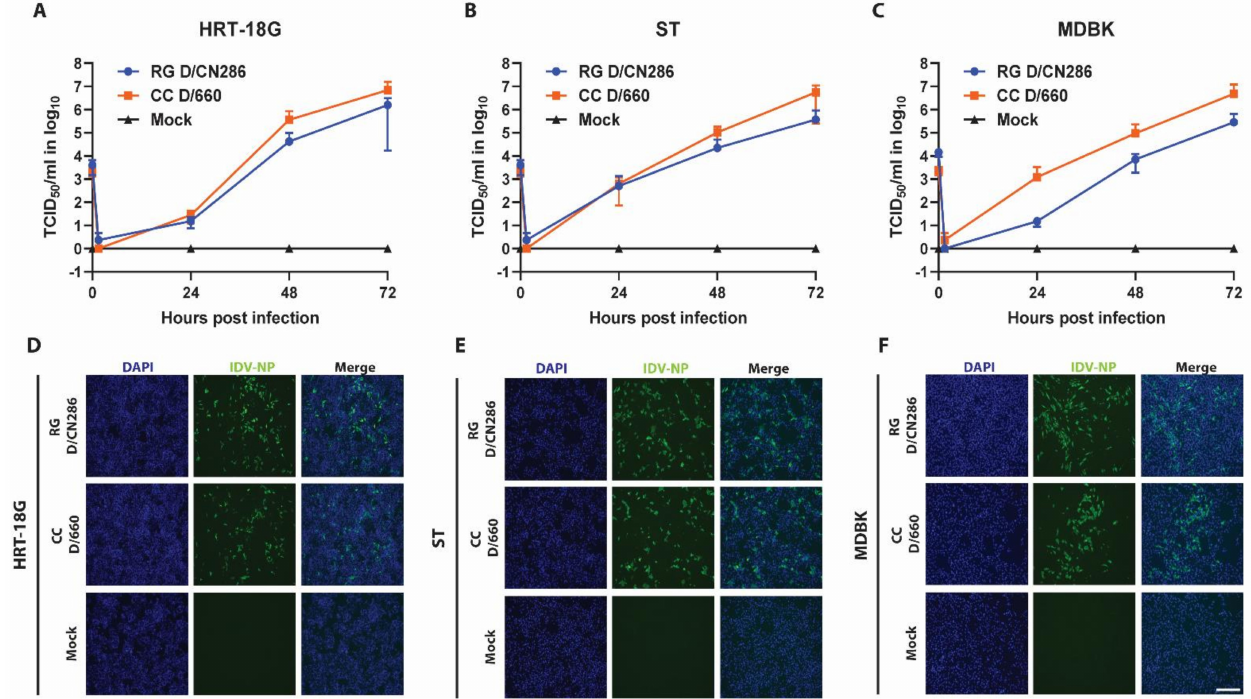
Figure 4. Replication kinetics of IDV on conventional cell lines. The replication kinetics of the reverse genetic D/CN286 clone were compared to the cell culture-adapted D/660 isolate on cell lines of human (HRT-18G, MOI: 0.01), porcine (ST, MOI: 0.01) and bovine (MDBK, MOI: 0.1) origin. Viral kinetics were monitored for 72 h with 24 h intervals. Values depicted at 0 h are the inoculum titres. Viral titres are given as TCID 50 /mL ( Y -axis) of the corresponding time points ( X -axis) for HRT-18G ( A ), ST ( B ) or MDBK cell lines ( C ). Data points are shown as means and SD of three individual experiments performed in two technical replicates. After 72 h of viral infection, cells were formalin-fixed and immunostained with the IDV-NP polyclonal antibody (Green) and DAPI (Blue). Representative microscopy images are shown of virus-infected and control culture for HRT-18G ( D ), ST ( E ) and MDBK cell lines ( F ). Images were acquired with a 10 × air objective. Scale bar represents 275 µ